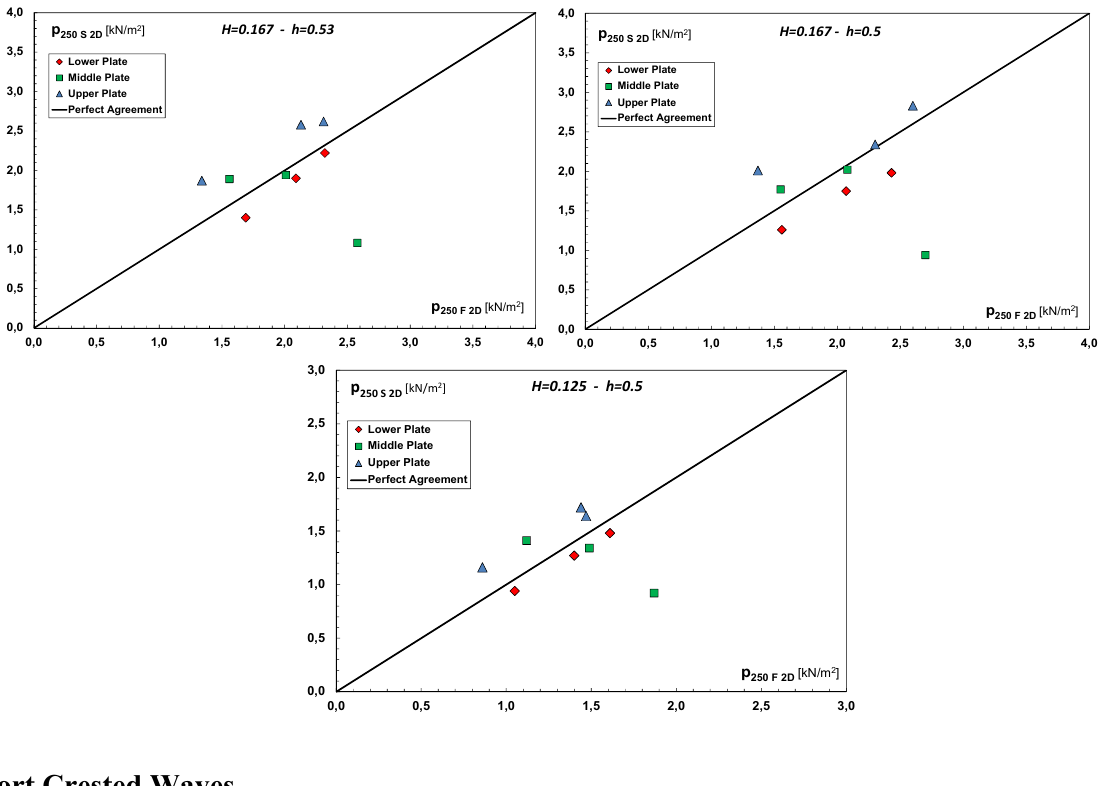
= 0.167 m, T = 1.81 s, h = 0.50 m. Low panel: s p